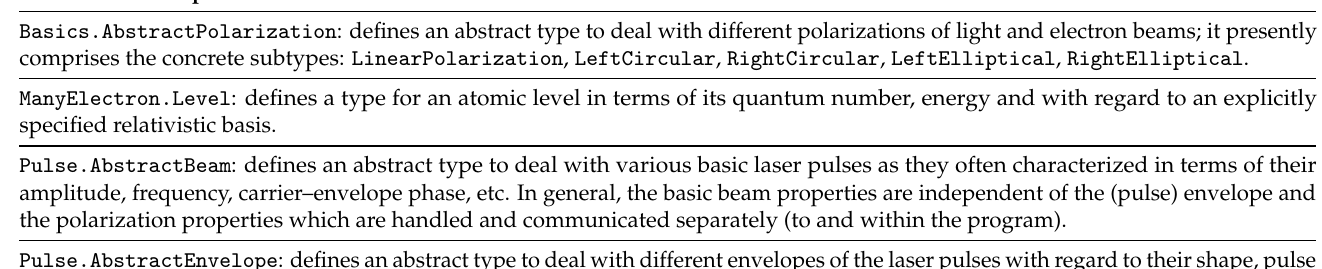
Table 1. Selected data structures of the J AC toolbox that are relevant for StrongField.Computation s. Here, only a brief explanation is given, while further details can be found by using Julia’s help